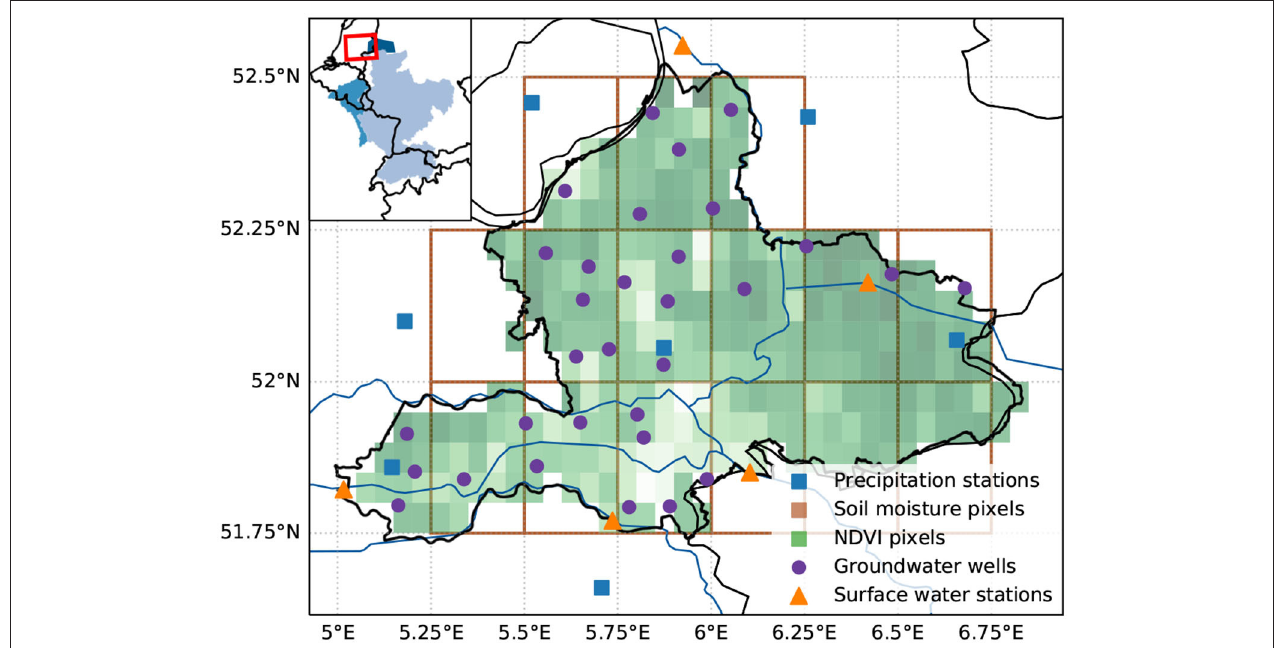
FIGURE 2 | Map of the study region and measurement locations. Inset figure shows the location of the main panel, including the three river basins corresponding to the water level and discharge stations: the Rhine (light blue), Meuse (medium blue), and Berkel (dark blue). Both soil moisture and NDVI products are gridded datasets. NDVI pixels are shaded based on their mean value over the entire period, ranging from 0.5 to 0.75.